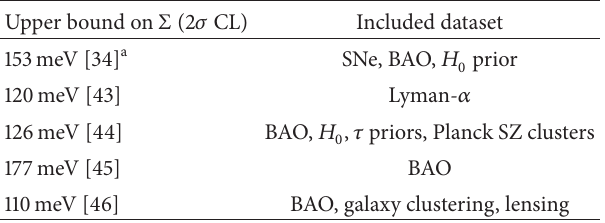
Table 4: Tight constraints on Σ obtained in 2015, by analyzing the data on the CMB by Planck Collaboration [34], polarization included, along with other relevant cosmological data probing smaller